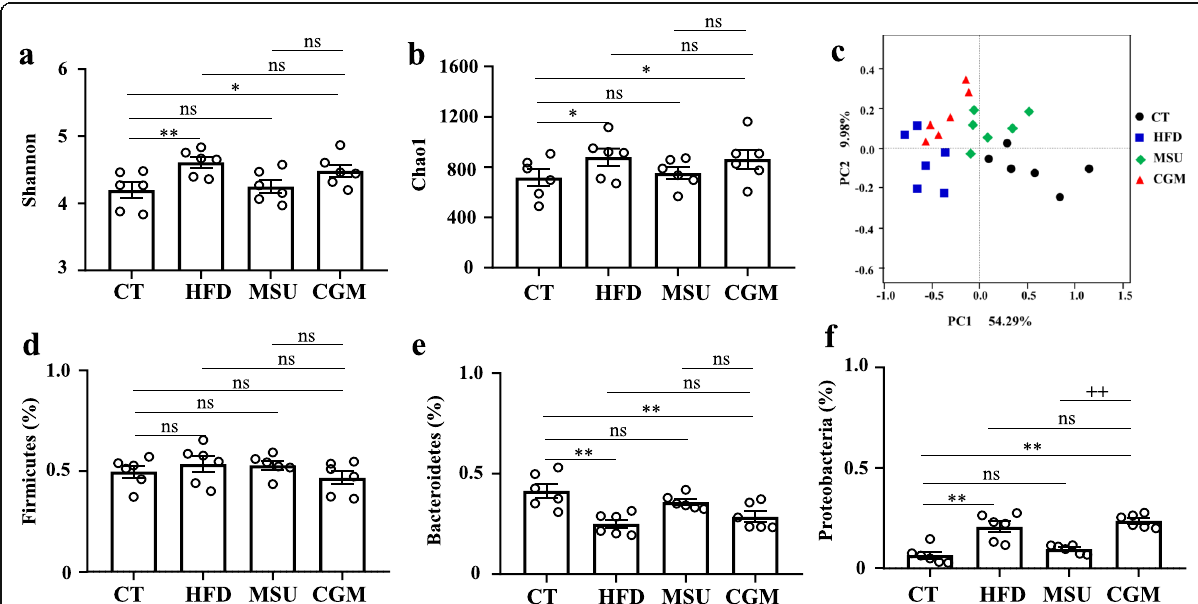
Fig. 4 Alterations of alpha diversity indexes [Shannon ( a ); Chao1 ( b )], PCoA score plot ( c ) and main phyla ( d , e and f ) of mice in the four groups. “ ns ” represents not significant; “ * ” represents p < 0.05 in comparison with CT; and “ ** ” represents p < 0.01 in comparison with CT; “ + ” represents p < 0.05 in comparison with CGM; and “ ++ ” represents p < 0.01 in comparison with CGM. CT: control group; HFD: hyperuricaemia model;